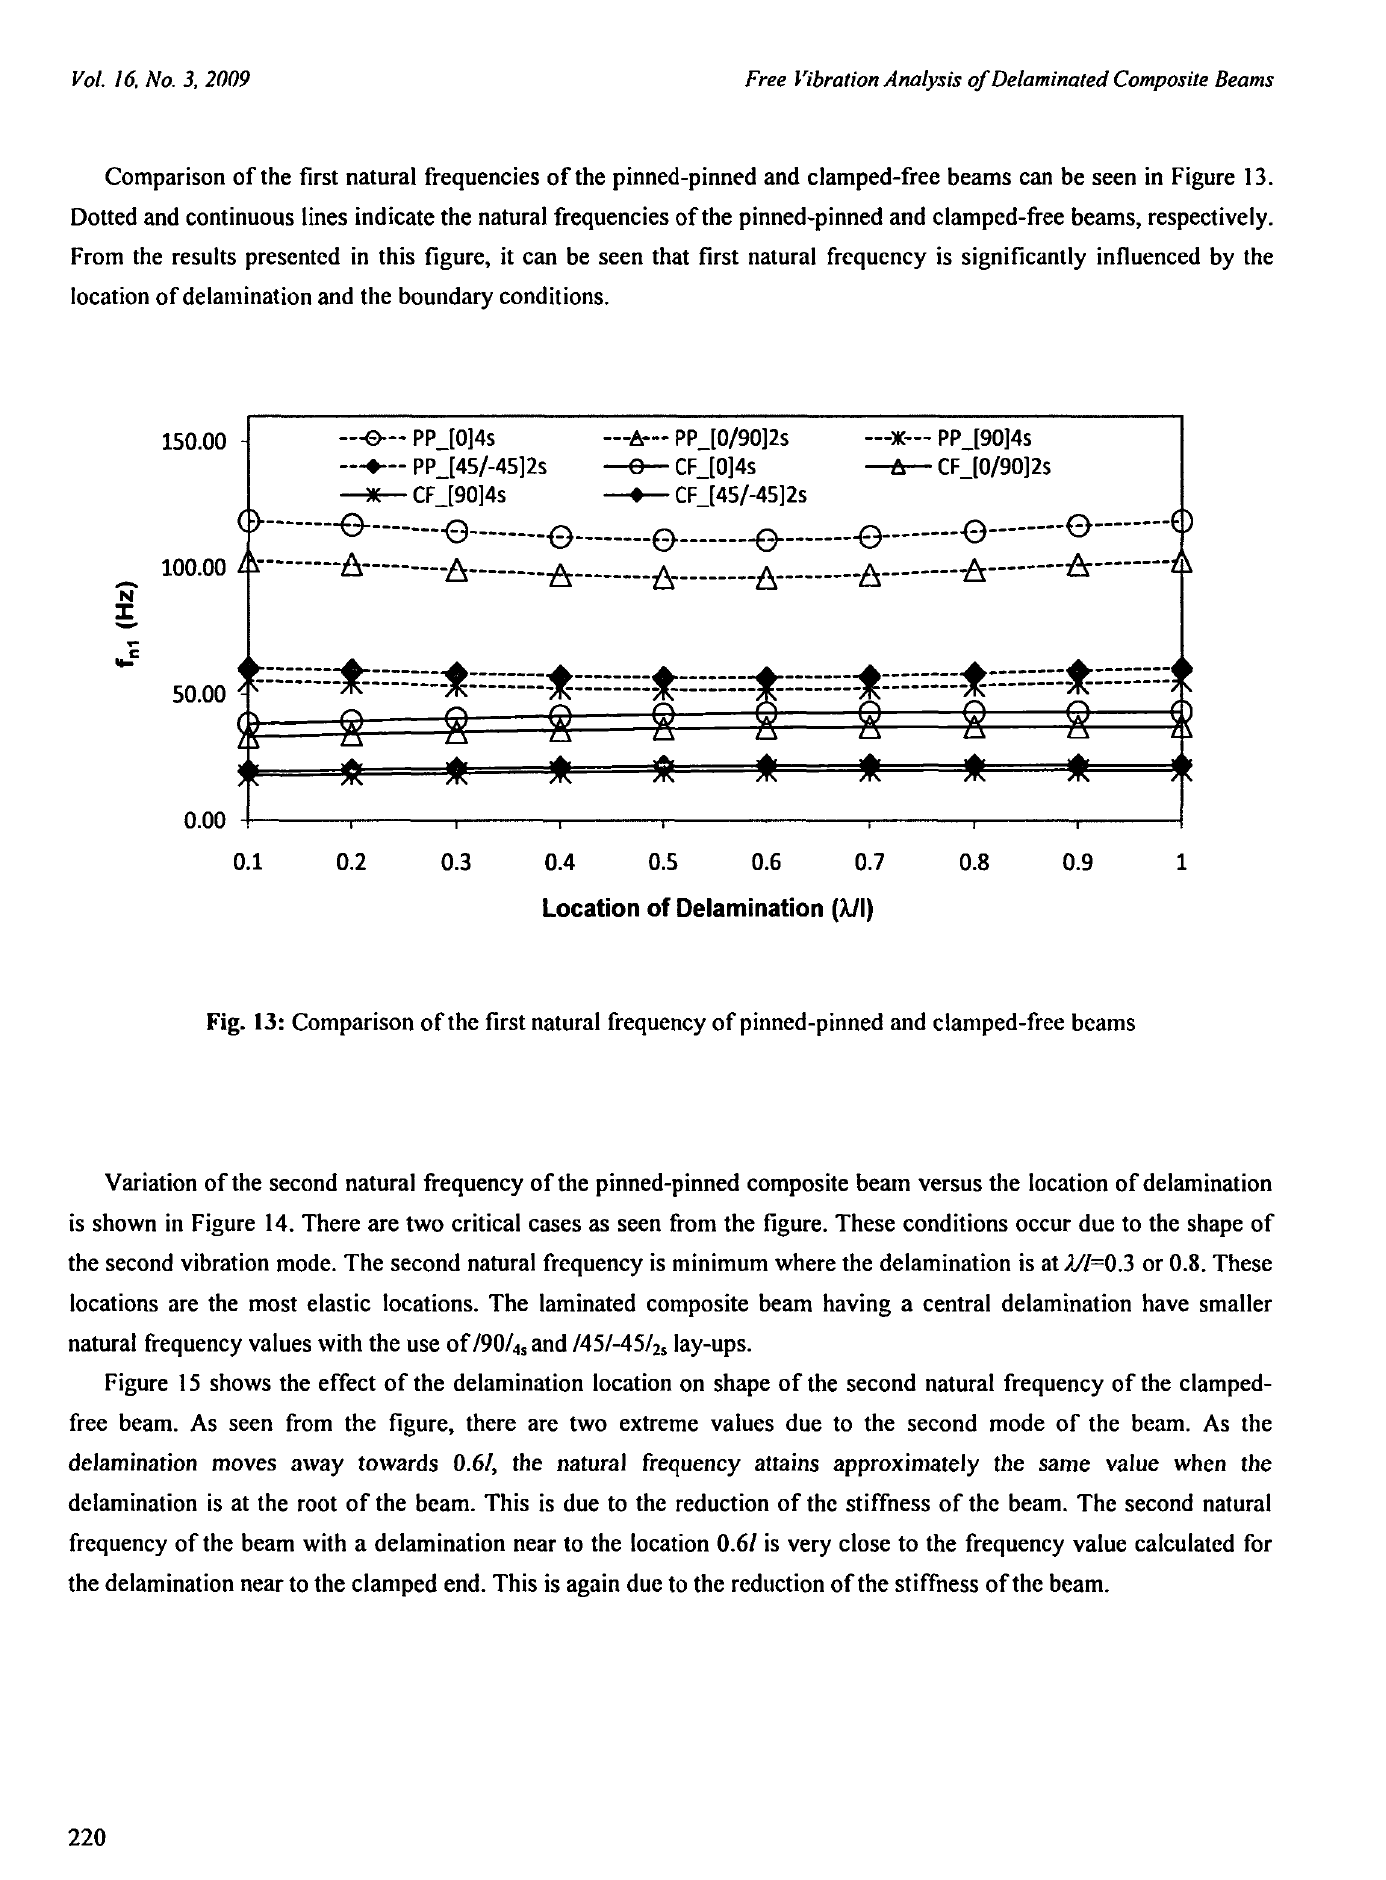
Fig. 13: Comparison of the first natural frequency of pinned-pinned and clamped-free beams